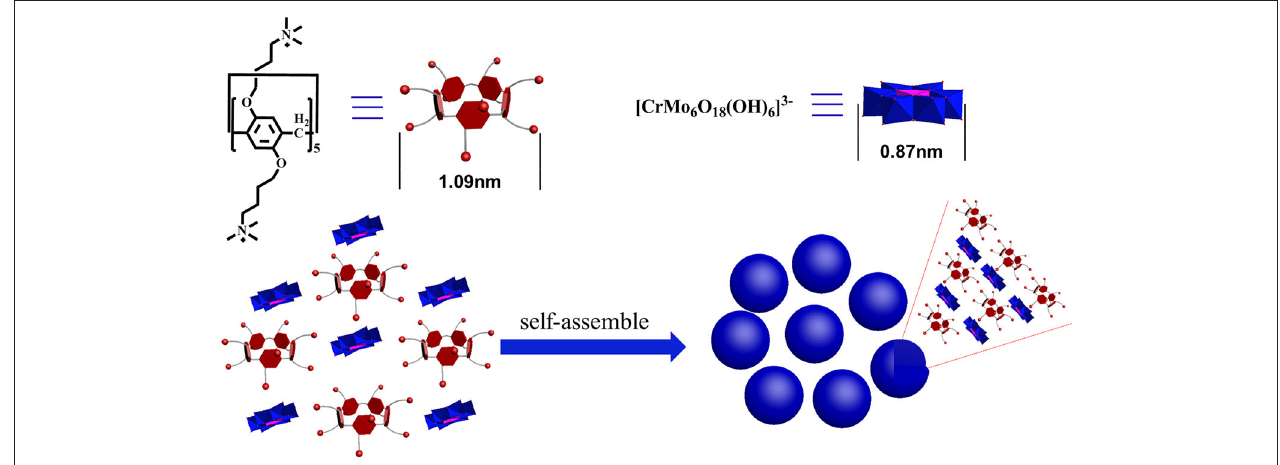
FIGURE 1 | Schematic representation of the two chemical structures and their self-assemblies.